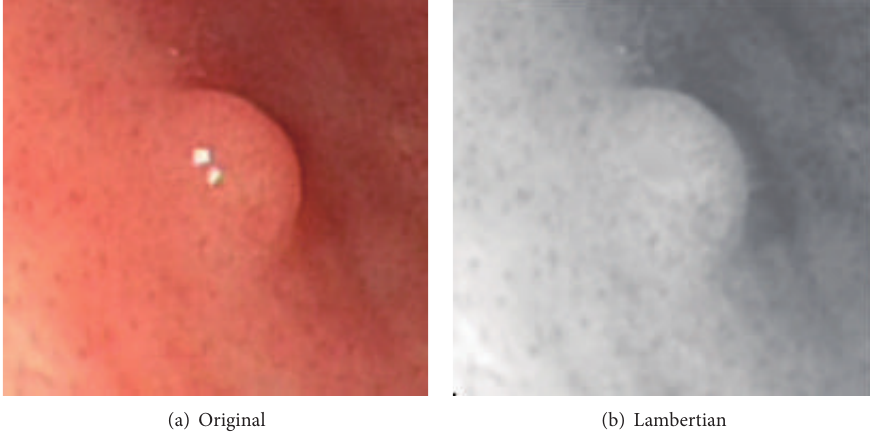
Figure 1: Endoscope image and Lambertian